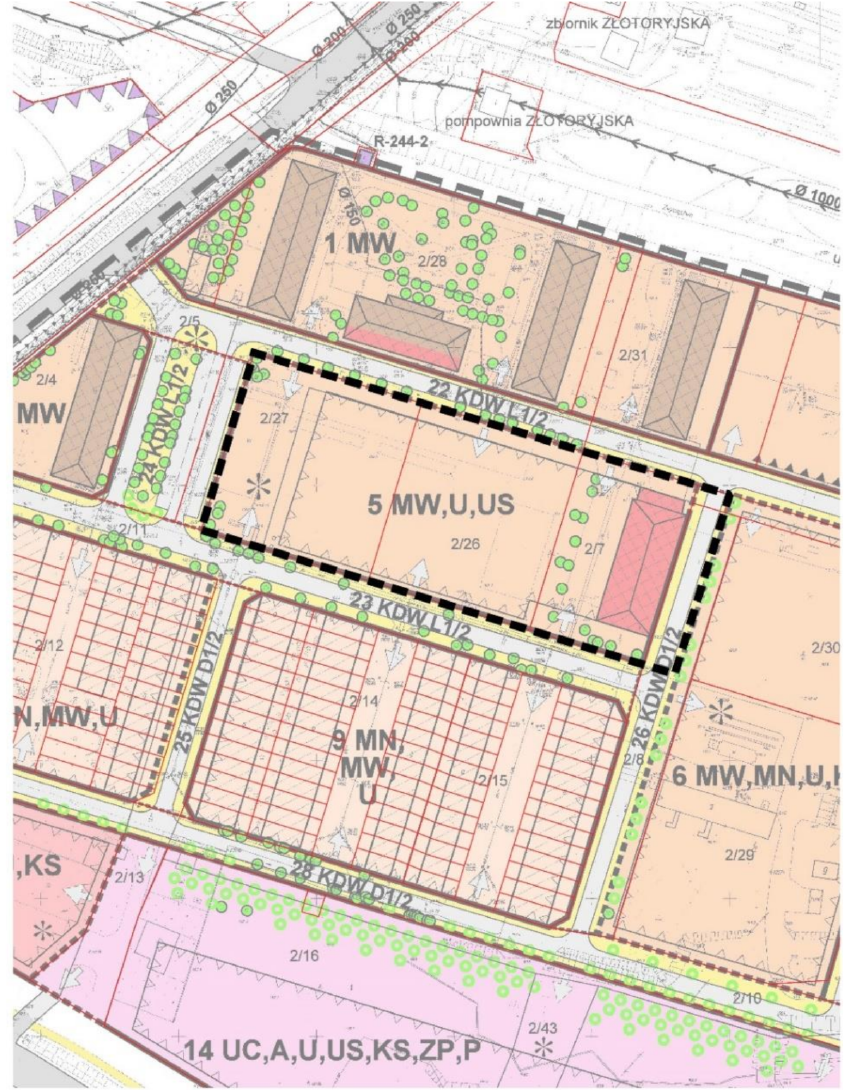
Figure 11. An excerpt from a zoning plan, which includes buildings on the training grounds in the Siegeshöhe barracks complex (source: http://um.bip.legnica.eu; accessed 19 July 2021). Barracks complexes, regardless of the period they were built in, constituted dense, autonomous quarters, comprised of various buildings. Headquarters and staff